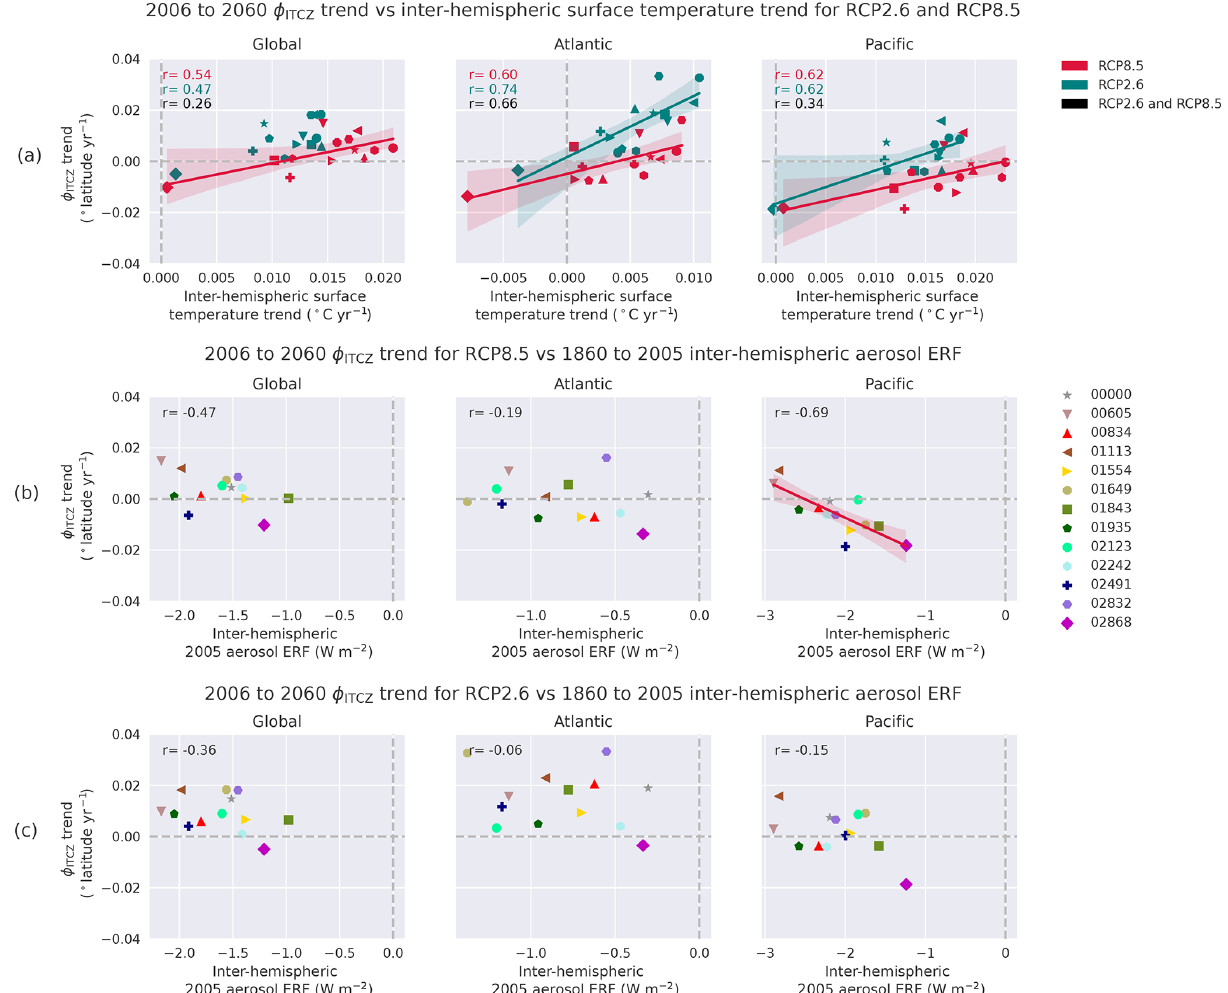
Figure 6. Scatter plot of trend in 5-year rolling mean (cid:56) ITCZ in 2006 to 2060 against the trend in inter-hemispheric (60 ◦ S–60 ◦ N) surface air temperature (a) and 1860 to 2005 anthropogenic aerosol ERF (b, c) for global (left), Atlantic (middle), and Pacific regional means (right). The Spearman rank correlation coefficient is shown at the top left of each plot. Trend lines are shown when r > 0 .